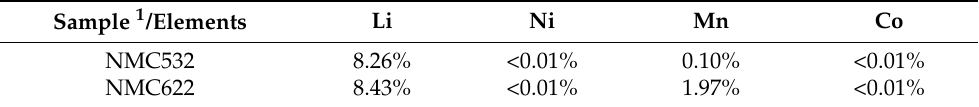
Table 7. Chemical composition of the deposition in the flue gas tube which accumulated during the InduMelt experiments (mass fraction,